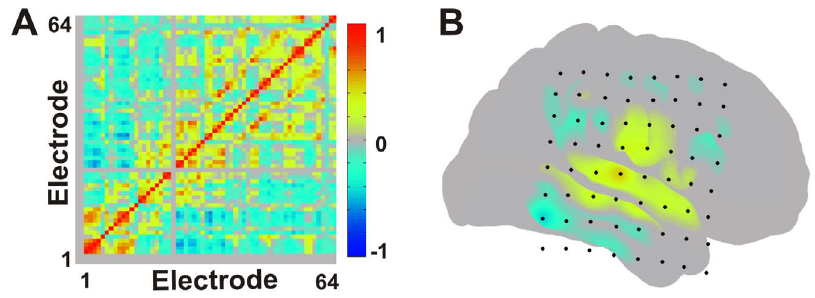
Figure 2. Correlation analysis. (A) Adjacency matrix depicting correlation coefficients between all electrodes across an entire 20 minute epoch (B) Cortical surface rendering of seizure network correlation structure when selecting the seizure focus seed for a single patient (Patient 2). Multiple comparison correction was performed using the false discovery rate method.